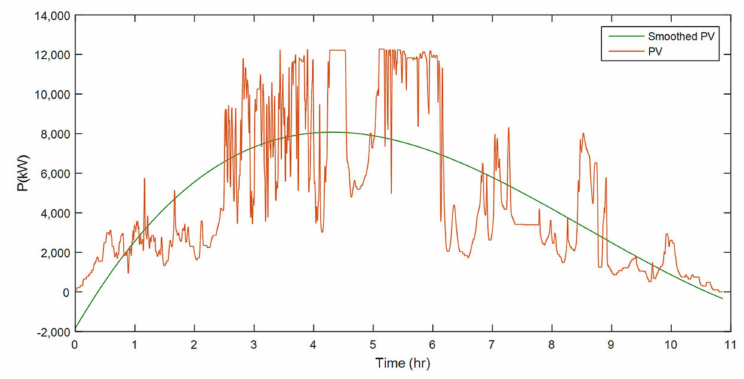
Figure 24. Actual and averaged PV power of day 28 August 2020.